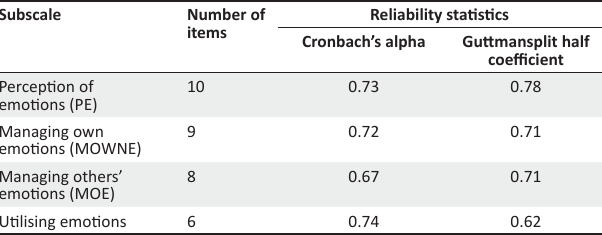
TABLE 3: Reliability statistics for the emotional intelligence subscales .